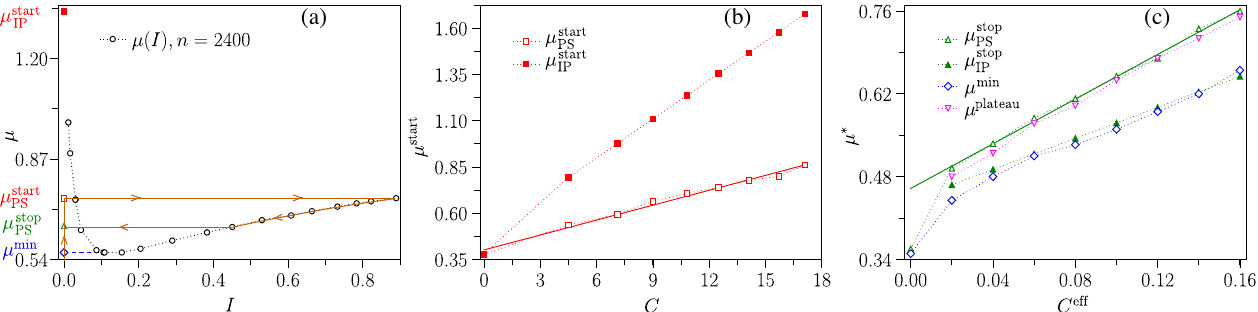
FIG. 6. Stress-imposed rheological measurements. (a) The starting μ start and the stopping μ stop friction coefficients for C eff ¼ 0 . 1 , PS PS measured using the plane shear cell, along with the intrinsic μ ð I Þ rheological curve, measured from shear-rate-imposed simulations. The brown line depicts the flow starting and stopping paths. The dashed line indicates μ min . The starting friction coefficient μ start , measured IP using the inclined plane, is also given. (b) μ start as a function of the cohesion number C for both the shear cell and the inclined plane (data from Ref. [13]). (c) Stopping μ stop , plateau μ plateau , minimum μ min friction coefficients measured using the shear cell, and μ stop measured IP PS using the inclined plane (data from Ref. [13]) as a function of the effective cohesion number C eff . The solid lines in (b) and (c) are the fits of the Mohr-Coulomb failure